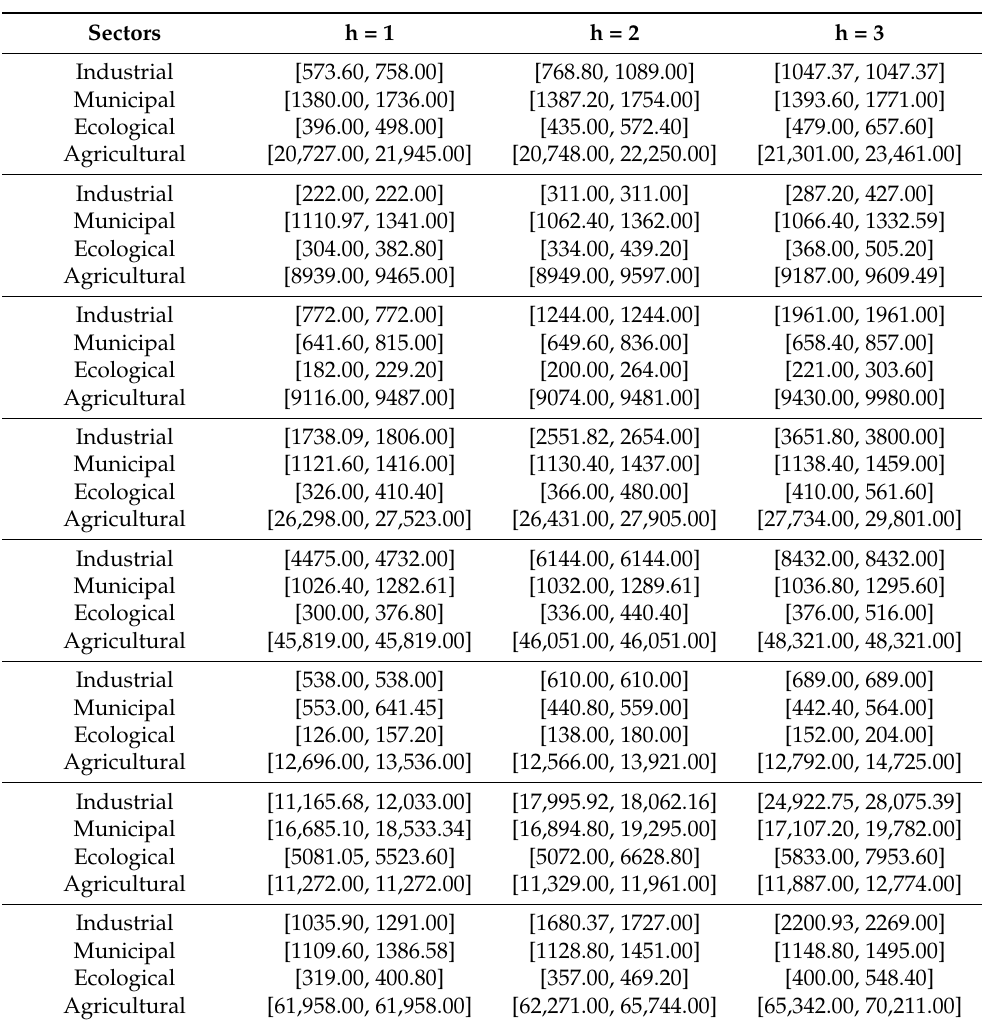
Table 2. Water allocation for different water-use sectors in various planning areas in the Yinma River Basin for each planning period (10 4 m 3